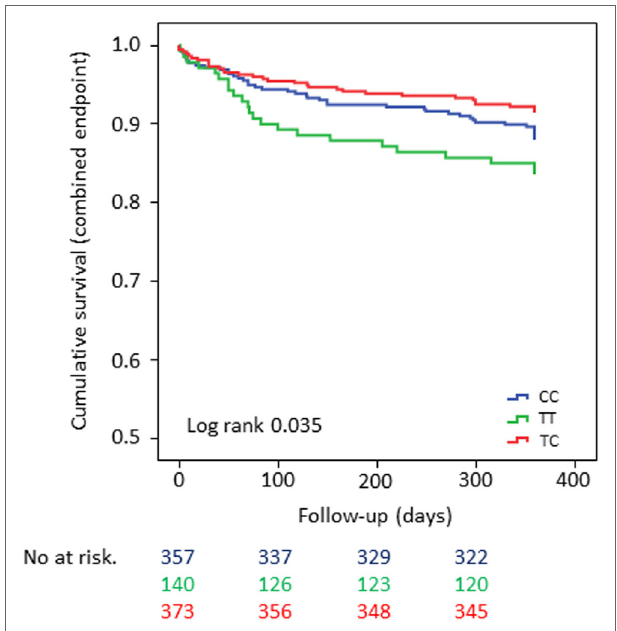
FigUre 1 | Kaplan–Meier curves showing cumulative survival (combined endpoint all-cause death and/or Ml and/or ischemic stroke) stratified according to GP la rs1126643 homozygous carriers of major allele, heterozygous and homozygous carriers of minor allele. No. at risk: